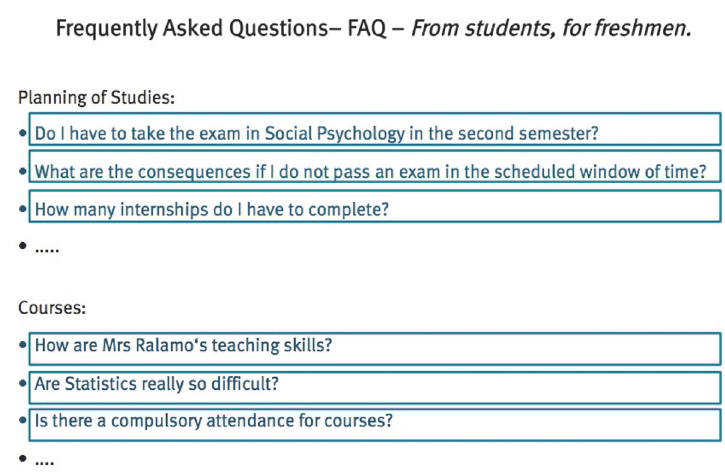
Figure 1: Screenshot of the question list shown to